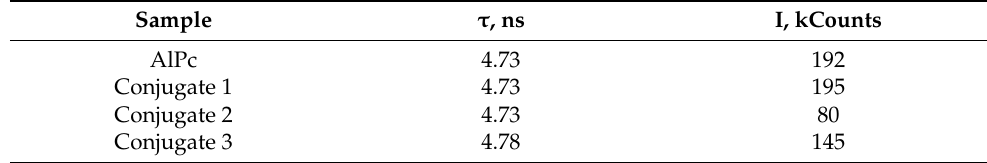
Table 3. Values of the characteristic luminescence decay times of the samples under study. Sample τ , Figure 2b. Upon excitation ( λ ex = 600 nm), the PS luminescence spectrum is clearly ob ‐ served. The luminescence lifetime of the obtained conjugates was measured in compari ‐ son with the fluorescence lifetime of pure PS, which dissolved in 0.1% NaOH aqueous solution (Figure 8).